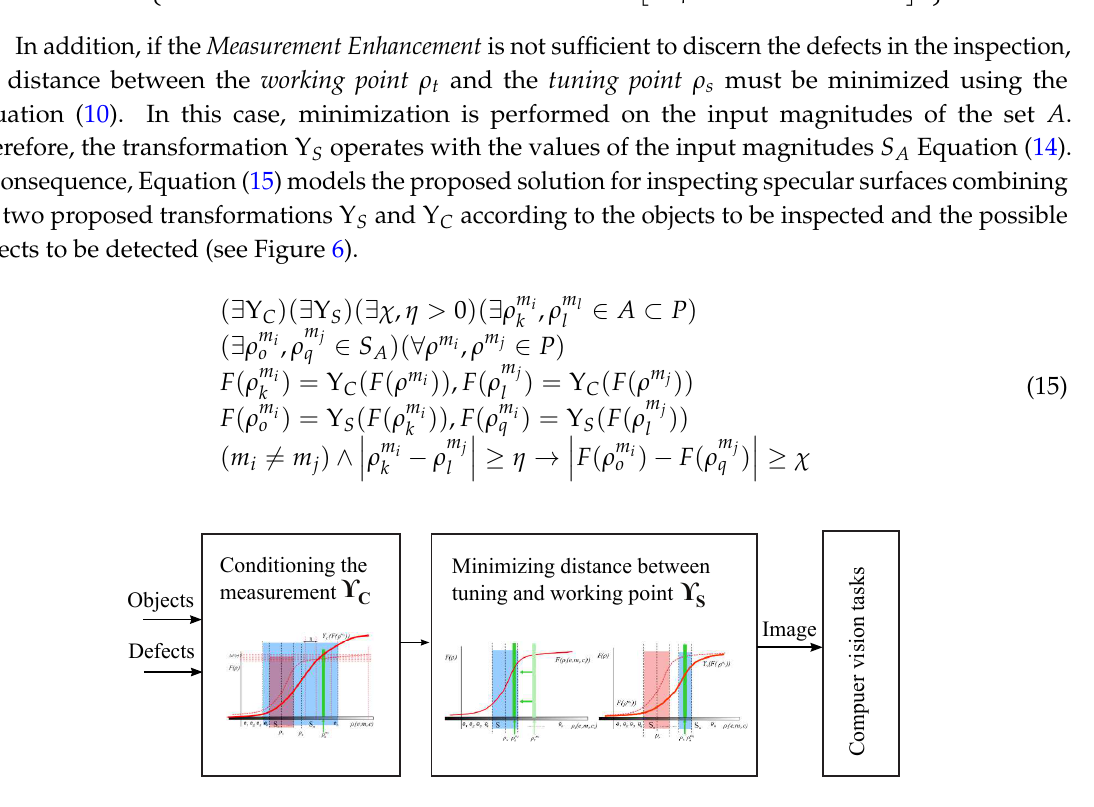
Figure 6. Method for inspecting specular surfaces. According to objects and defects, transformations Υ Υ S and C are selected to provide an image in which defects can be detected using computer vision